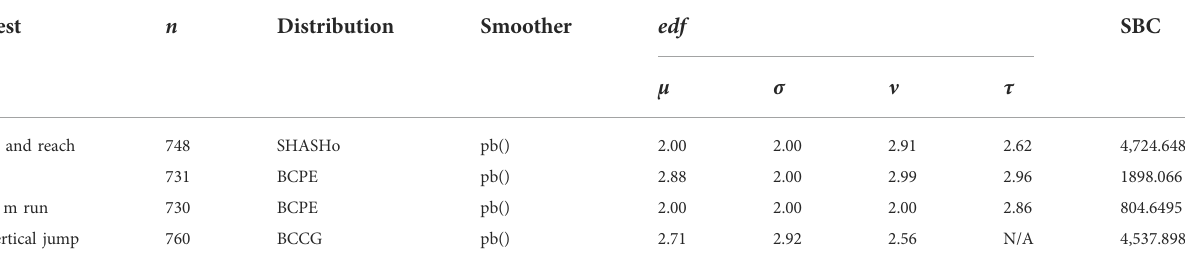
TABLE 2 Summary of fi tted GAMLSS model